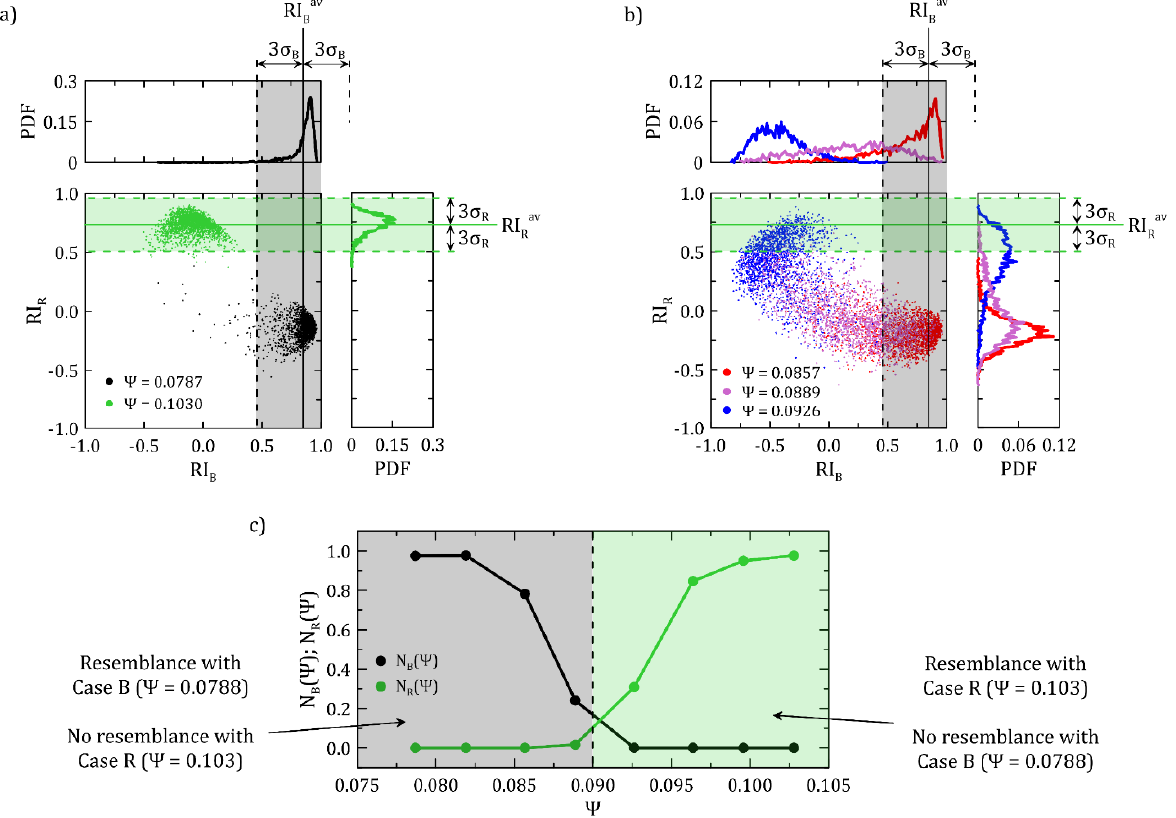
Figure 6. Resemblance index properties: ( a ) scatter plots of RI B and RI R for the reference cases; ( b ) scatter plots of RI B and RI R at ψ = 0.0857, 0.0889, and 0.0925; ( c ) N B and N R dependence on ψ .